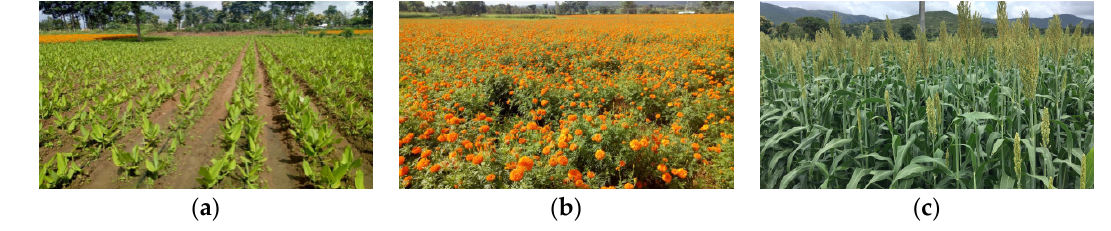
Figure 2. Illustration of three agricultural fields: ( a ) turmeric, ( b ) marigold, ( c ) sorghum. Soil moisture and leaf area index measurements were recorded on each reference plot, at the beginning of the ground campaign for a selected number of reference plots.